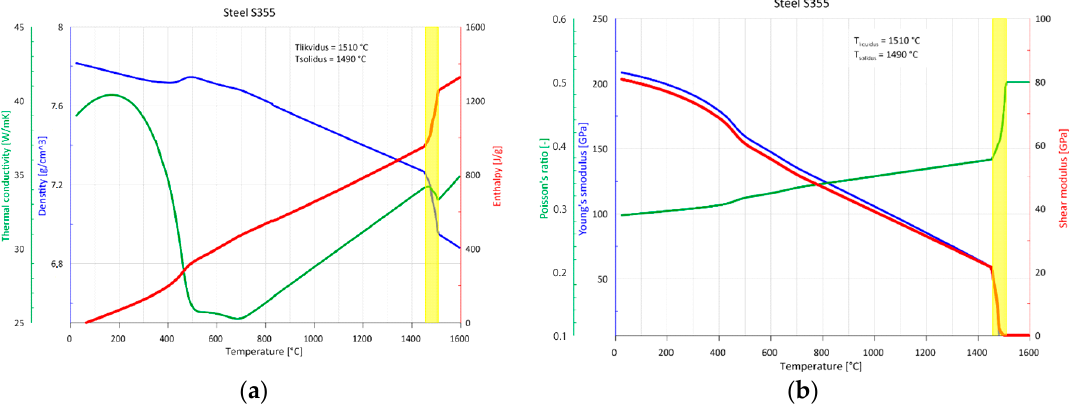
Figure 6. Temperature dependent physical properties for the steel grade S355, ( a ) thermophysical properties; ( b ) Mechanical properties.